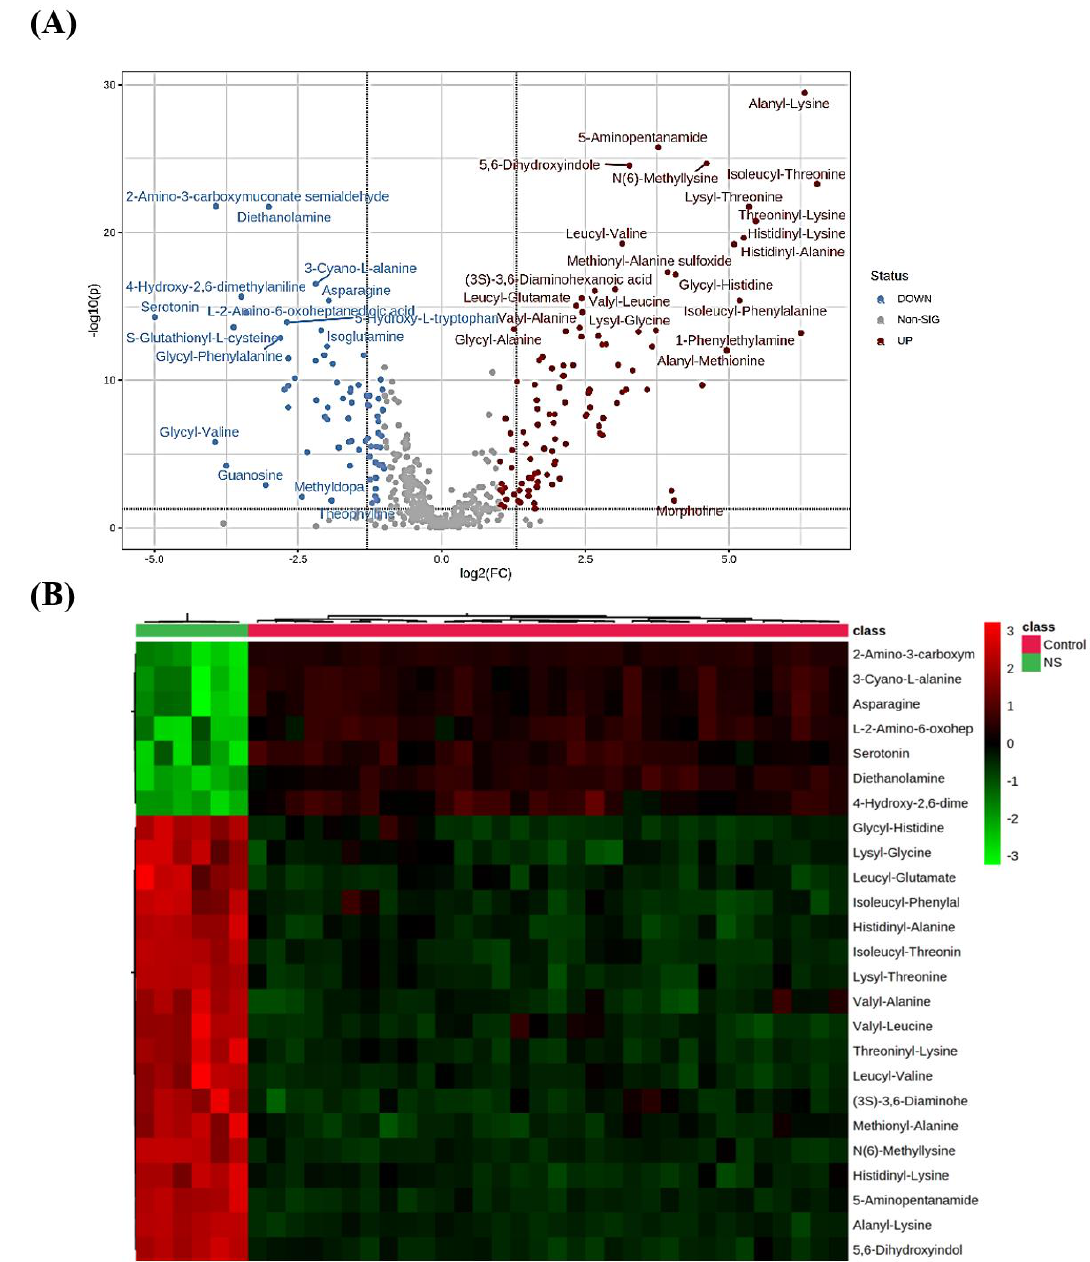
Figure 2. Binary comparison for serum samples of patients with NS and healthy controls. ( A ) Dysregulated metabolites between NS vs. control with fold change cut-off of 2 and false discovery rate (FDR) threshold of 0.05; up-regulated = 105 (red), down-regulated = 71 (blue). ( B ) Hierarchal clustering (HAC) and heat map analysis of the top 25 significantly altered metabolites between the two study groups; controls (red), and NS (green).